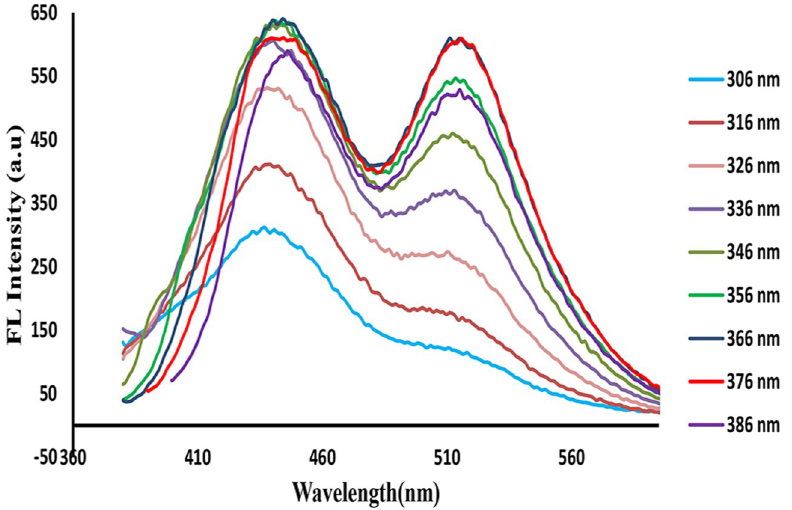
Figure 5. The emission spectra of Zn/Cl-CQDs /riboflavin system under various excitation wavelength from 306 to 386